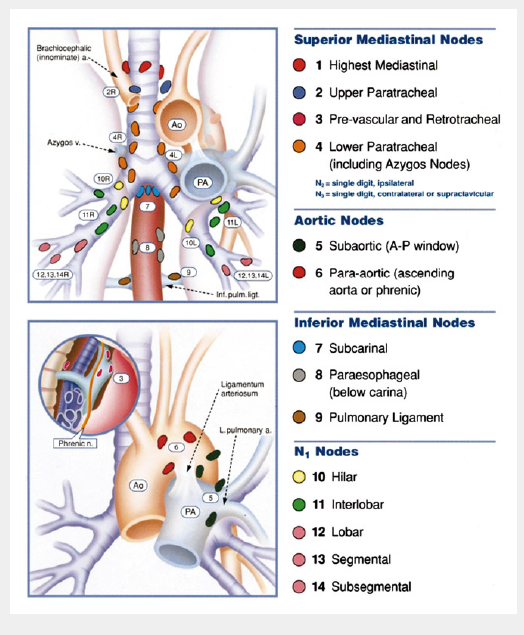
Regional lymph node stations for lung cancer staging (from Mountain CF, Dresler CM. Chest 1997;11:1718–23 [12]; reprint with